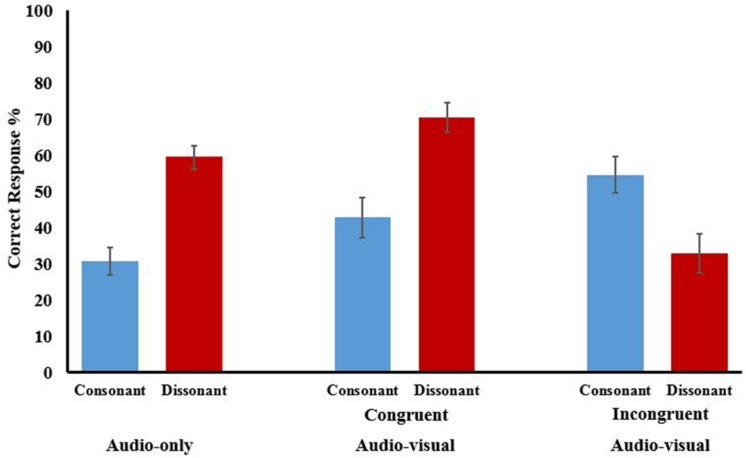
Correct response (%) for parallel line discrimination when trials used congruent and incongruent audio–visual stimuli. Means are shown for consonant (blue) and dissonant (red) intervals for audio-only and audio–visual conditions. Error bars show ±1 SEM.